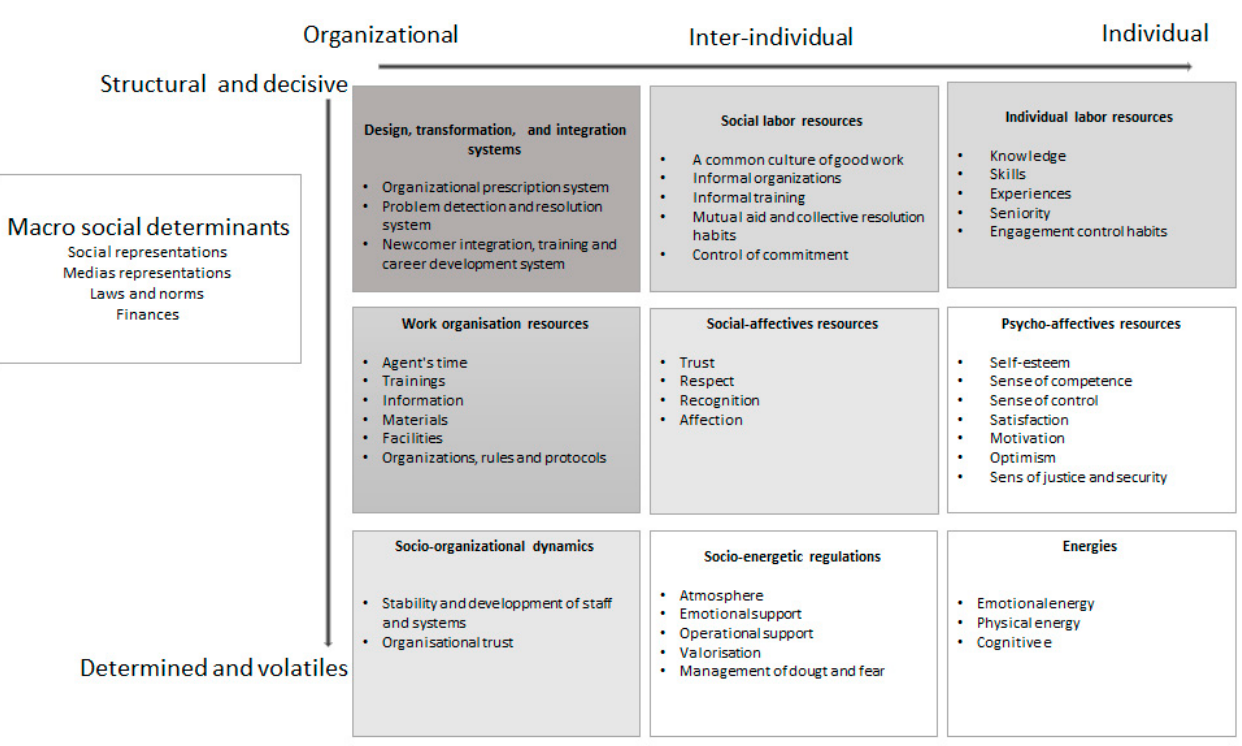
Figure 4. Summary of observed resources.